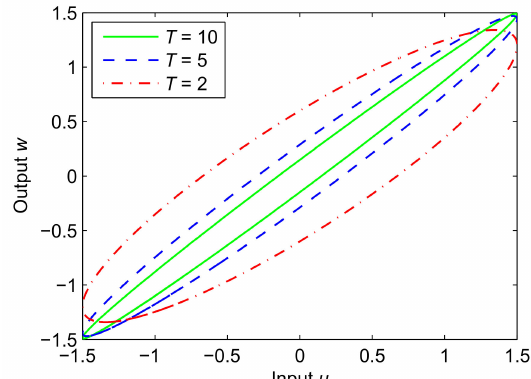
Figure 2. The hysteresis characteristics of the inertial system with input: u = 1.5sin(2 π t ), when T = 2, 5 and